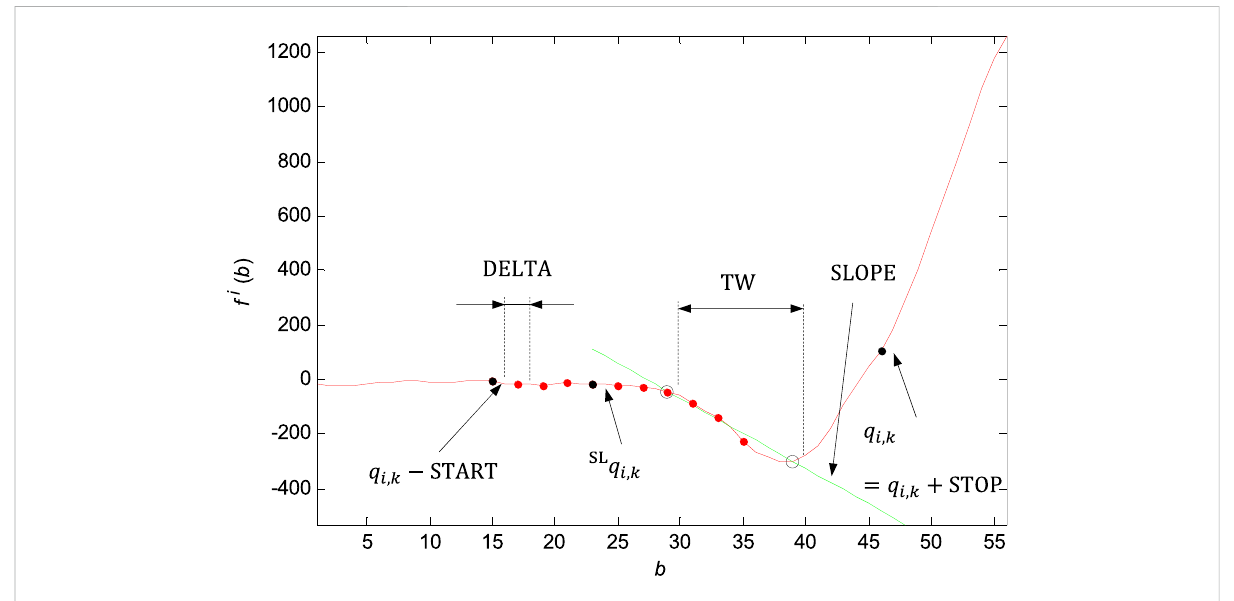
FIGURE 9 Marking of the shifting window with the width of TW, initial point in the q i , k − START point, end point in the q i , k (cid:2) q i , k + STOP point and shift step DELTA. In each window, there is the line slope SLOPE evaluated. In the case of the QRS onset and offset adjustment, the line slope is evaluated only from the initial and end points of the window. The new point SL q i , k marked in the graph is de fi ned based on the TH SLOPE